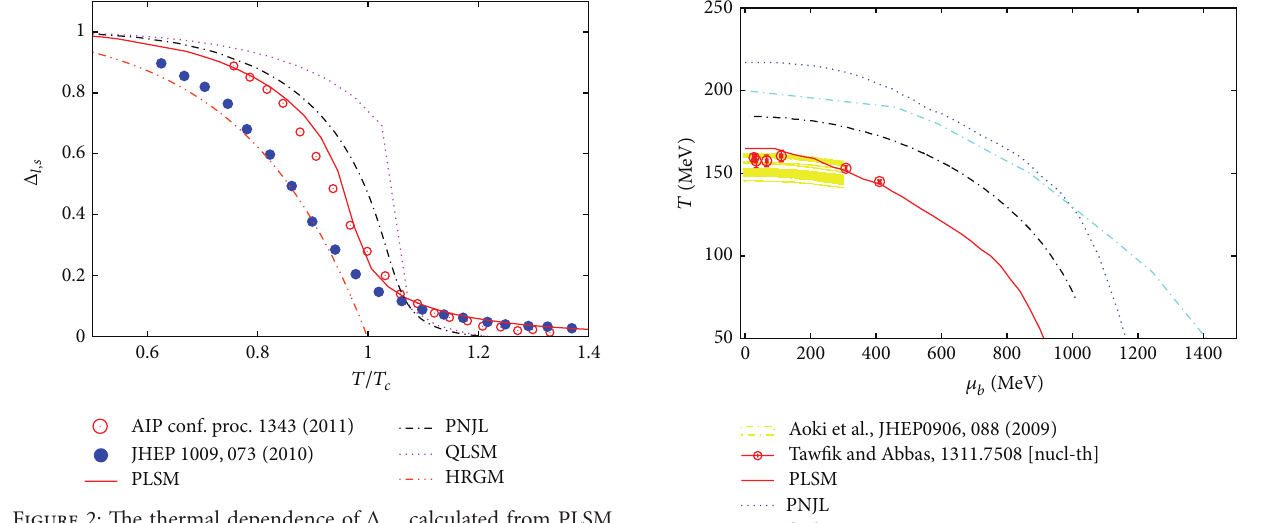
Figure 2: The thermal dependence of Δ 𝑞,𝑠 calculated from PLSM (solid curve), QLSM (dotted curve), PNJL (double-dotted curve), and HRG (dash-double-dotted curve) and compared with the lattice QCD calculations (solid circles) [47] and (open circles) [49] at /𝑚 = 0.037 . 𝑚 𝑙 𝑠